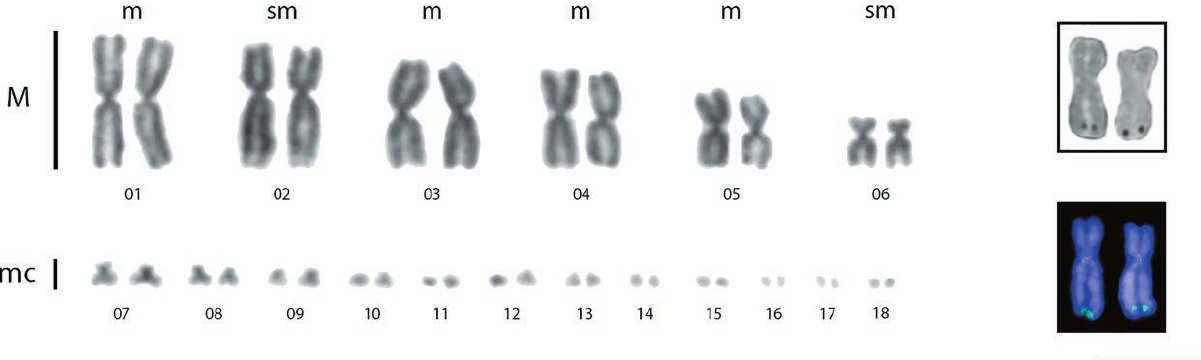
Figure 1. Giemsa-stained karyotypes of Enyalius boulengeri. Insets present chromosome pairs with Ag-NOR (above) and 18S rDNA (below) identified on chromosome pair number 2. Scale bars indicate 5 μm.